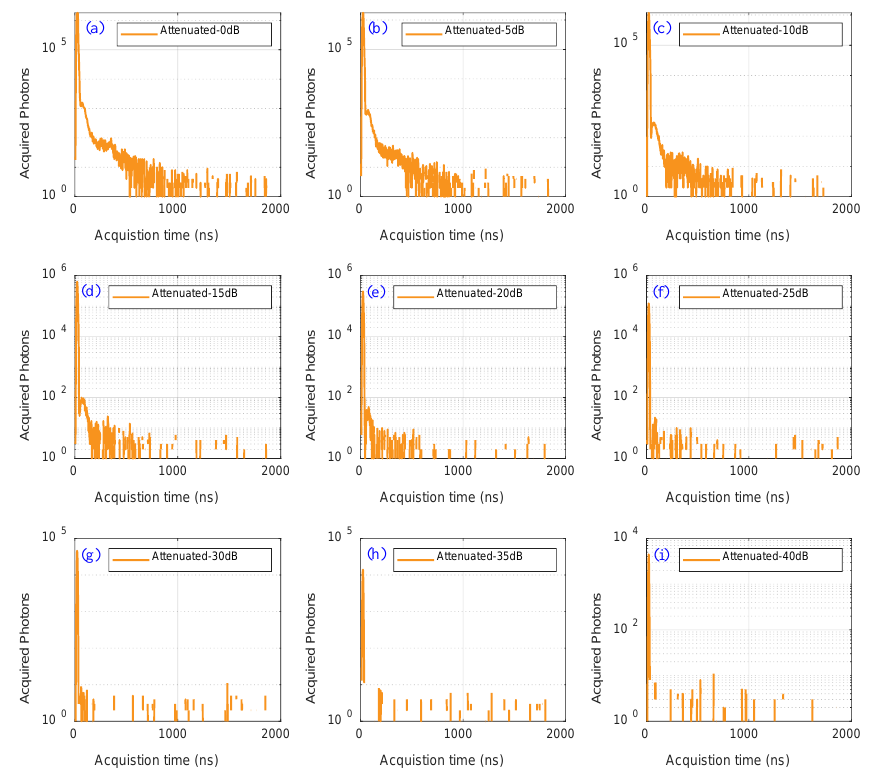
Figure 6. Distribution of the APC from attenuation of 0 to − 40 dB. ( a ) attenuation of 0 dB; ( b ) attenuation of − 5 dB; ( c ) attenuation of − 10 dB; ( d ) attenuation of − 15 dB; ( e ) attenuation of − 20 dB; ( f ) attenuation of − 25 dB; ( g ) attenuation of − 30 dB; ( h ) attenuation of − 35 dB; ( i ) attenuation of − 40 dB.